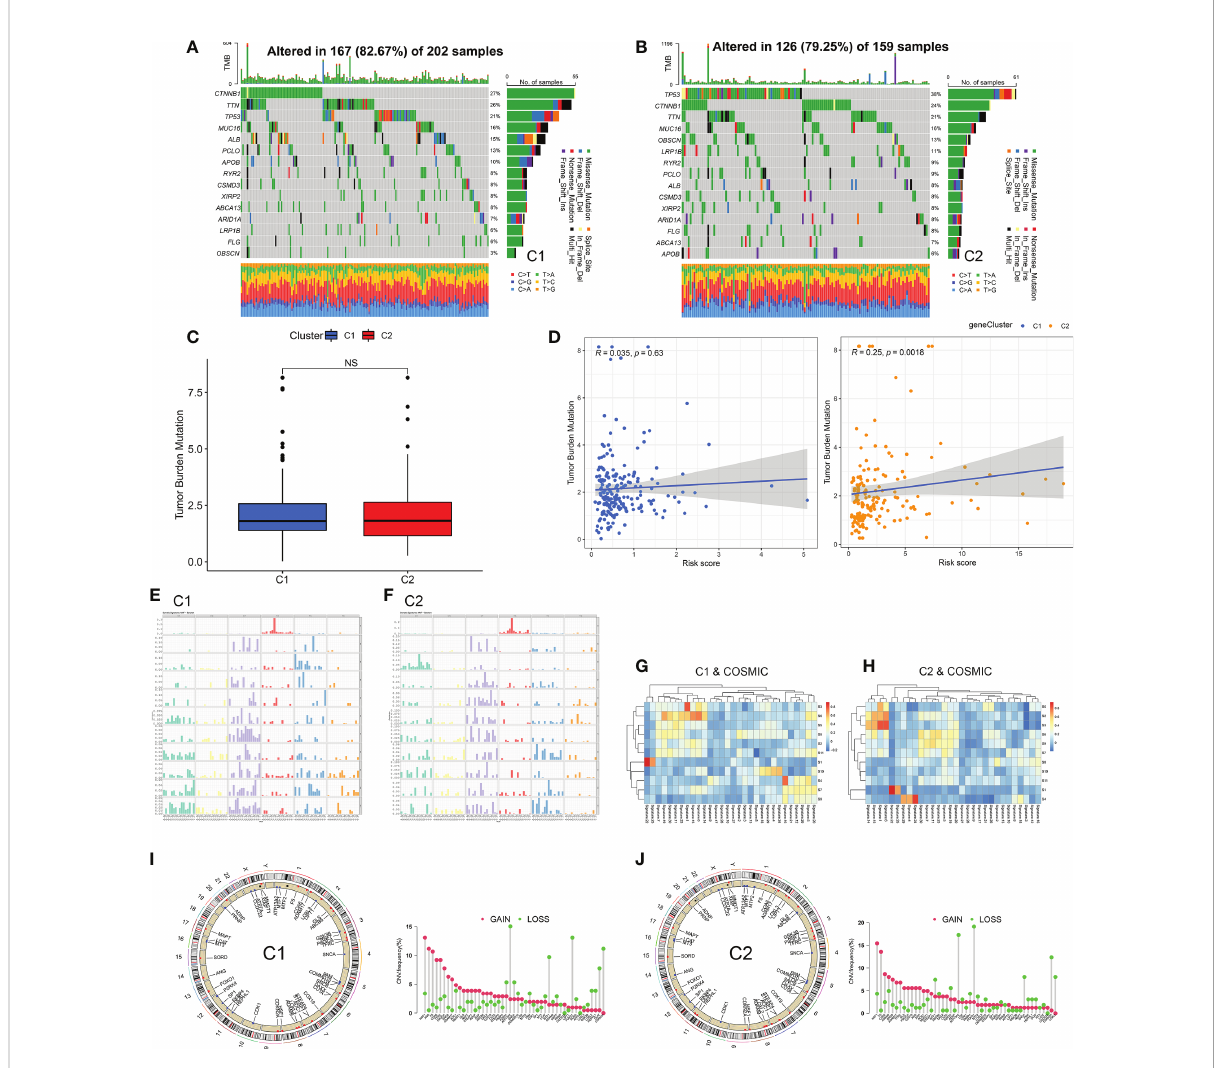
FIGURE 8 Identi fi cation of subtype mutation characteristics. (A, B) Immune mutation landscape of driving genes. (C, D) Correlation analysis of mutation load and risk score of copper metabolism and cuproptosis-related genes among subtypes. (E, F) Frequency spectrum of somatic mutation between subtypes. (G, H) The spectrum of somatic mutations between subtypes was analyzed jointly with COSOMIC database. (I, J) CNV analysis of copper metabolism and cuproptosis-related genes among subtypes. NS: Not Signi fi